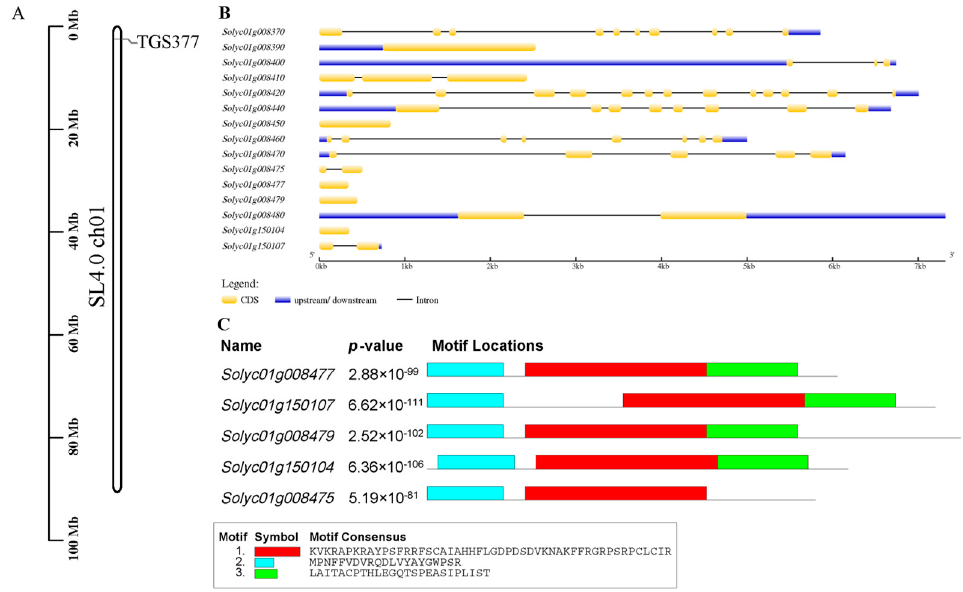
Figure 2. Chromosome position map of TGS377 and analysis of upstream and downstream 50 kb gene structure of tomato. ( A ) Chromosome position map of TGS377 molecular marker; ( B ) Gene structure analysis; ( C ) Motif analysis.